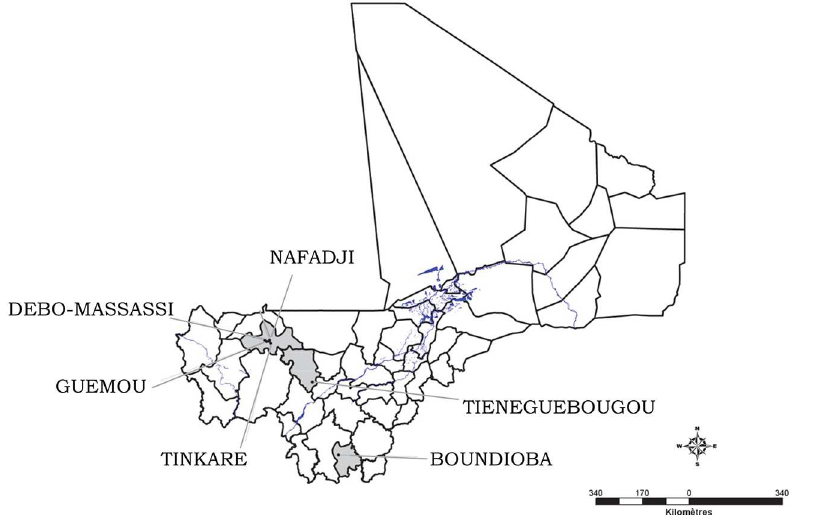
Fig 1. Map of Mali showing the study sites in different